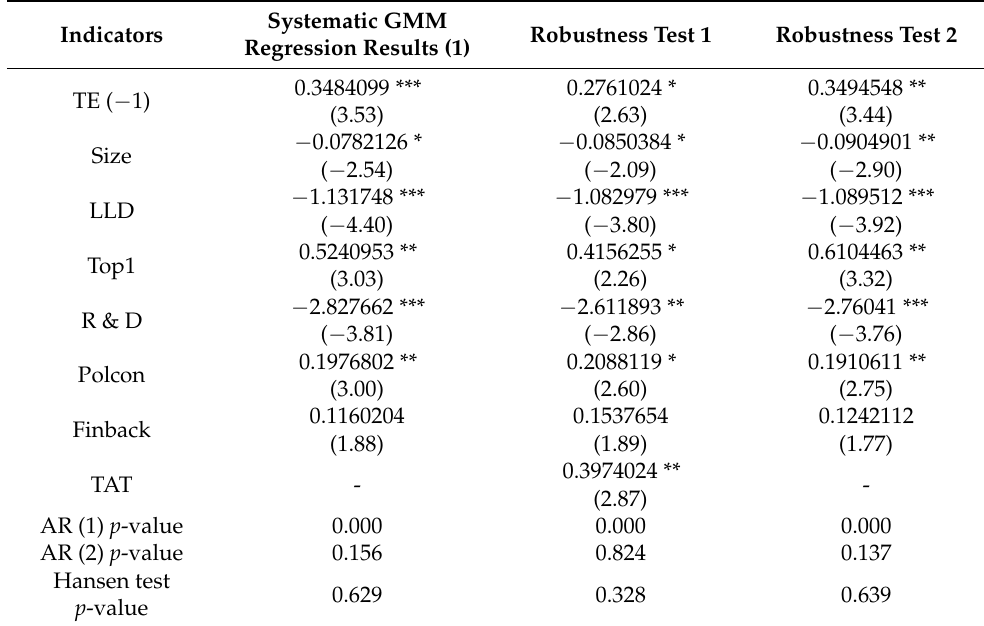
Table 8. Systematic GMM regression results and robustness